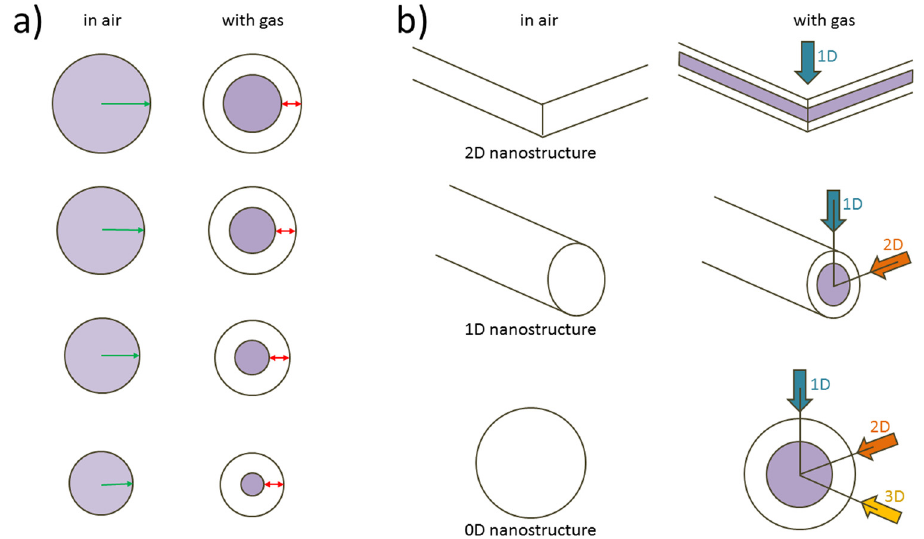
Figure 2: ( a ) Section of a nanowire in air and in the presence of gas. The white annular section is the depletion layer, while the purple - colored part contributes to the signal. ( b ) The modulation of the depletion layer acts on the number of nanometric